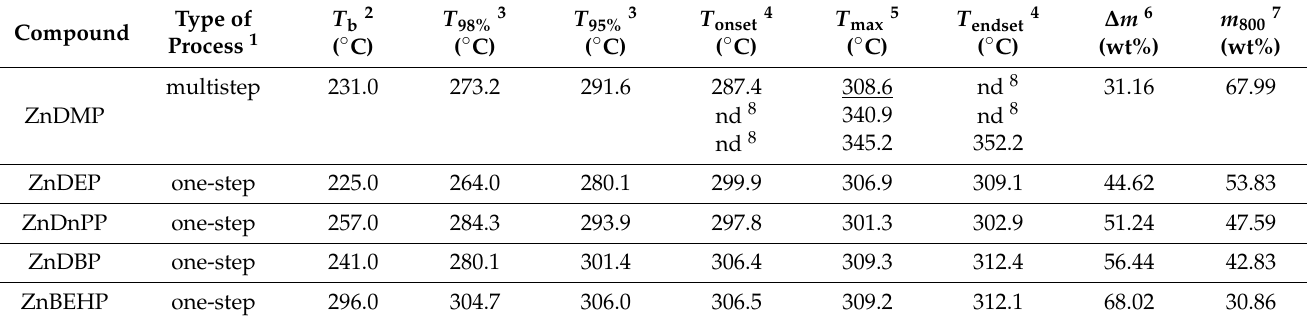
Table 1. Thermogravimetric data of aliphatic ZnDOPs measured in